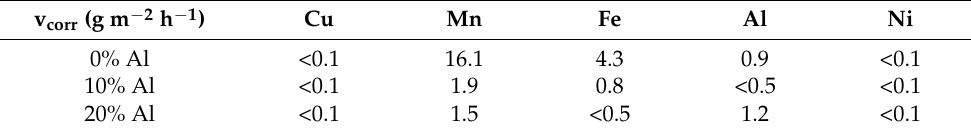
Table 6. The corrosion rate of elements in model seawater at E = − 0.145 V/SCE.